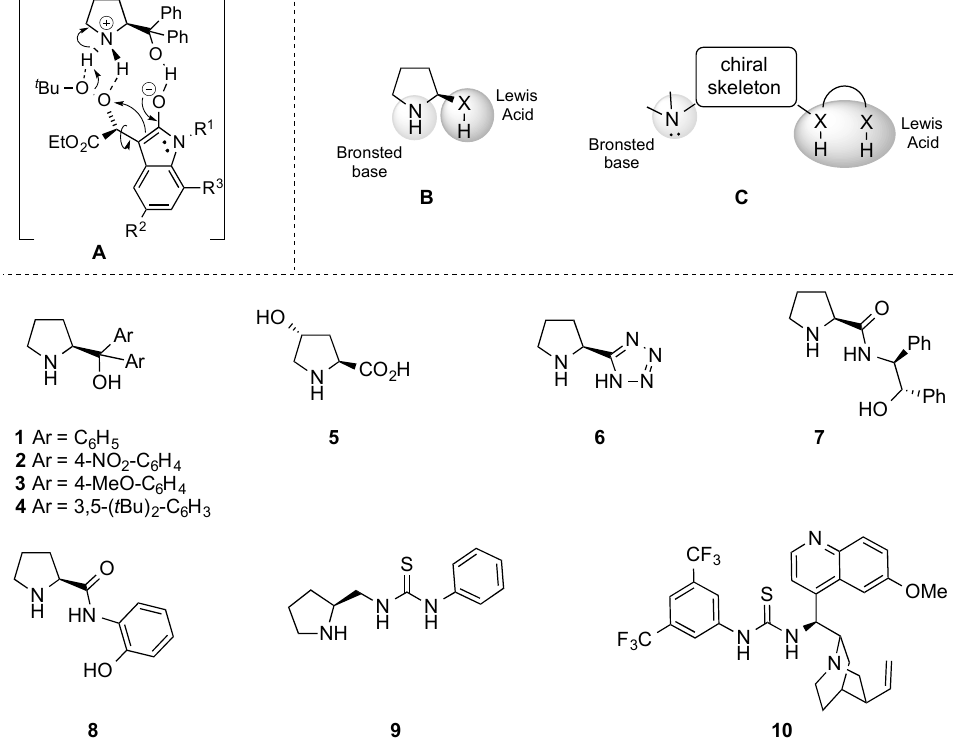
Figure 1. Postulated transition state ( A ) of the previously optimized organocatalytic epoxidation that highlights the substrate/catalyst/oxidant H-bond network. Hypothesized catalyst structures ( B , C ). Organocatalysts examined in this study ( 1 – 10 ).